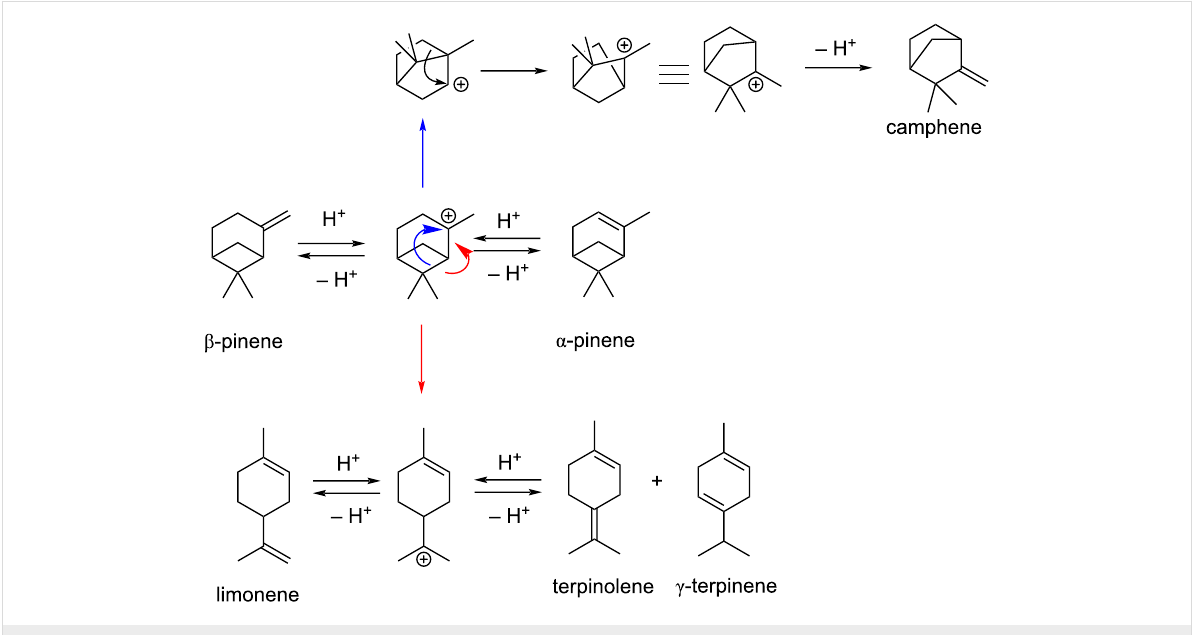
Scheme 4: Possible isomerization products from β -pinene and α -pinene.